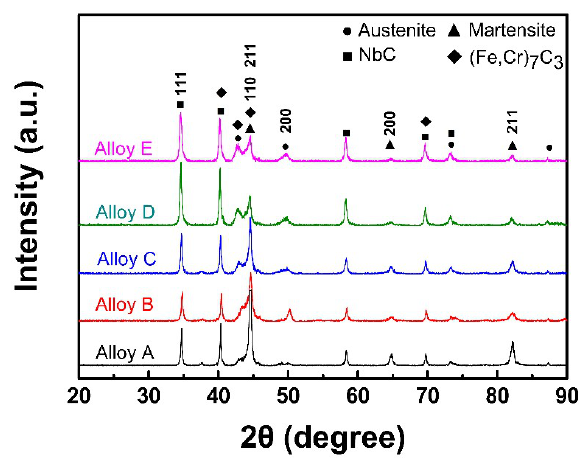
Figure 1. XRD spectra of various coatings with different levels of Nb addition.